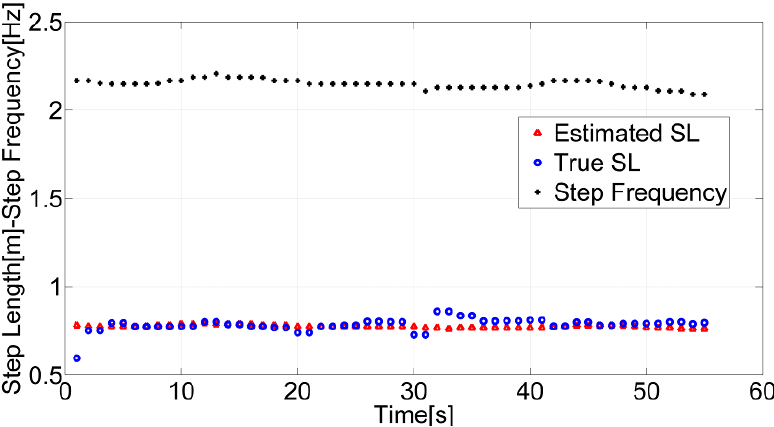
Figure 6. Estimated, true step lengths and step frequencies computed with signals from a handheld IMU when the user is walking with his hand